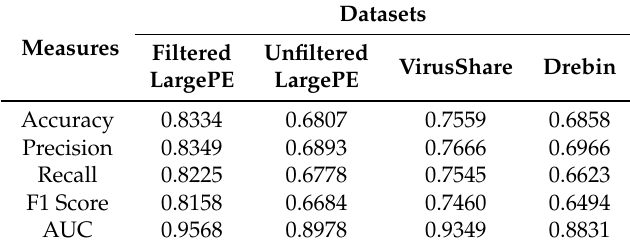
Figure 6. Confusion matrix of first 20 classes in meta-testing set of LargePE dataset. Weights less than 0.01 are omitted. Table 5. Performance assessment measures for 5-shot 5-way